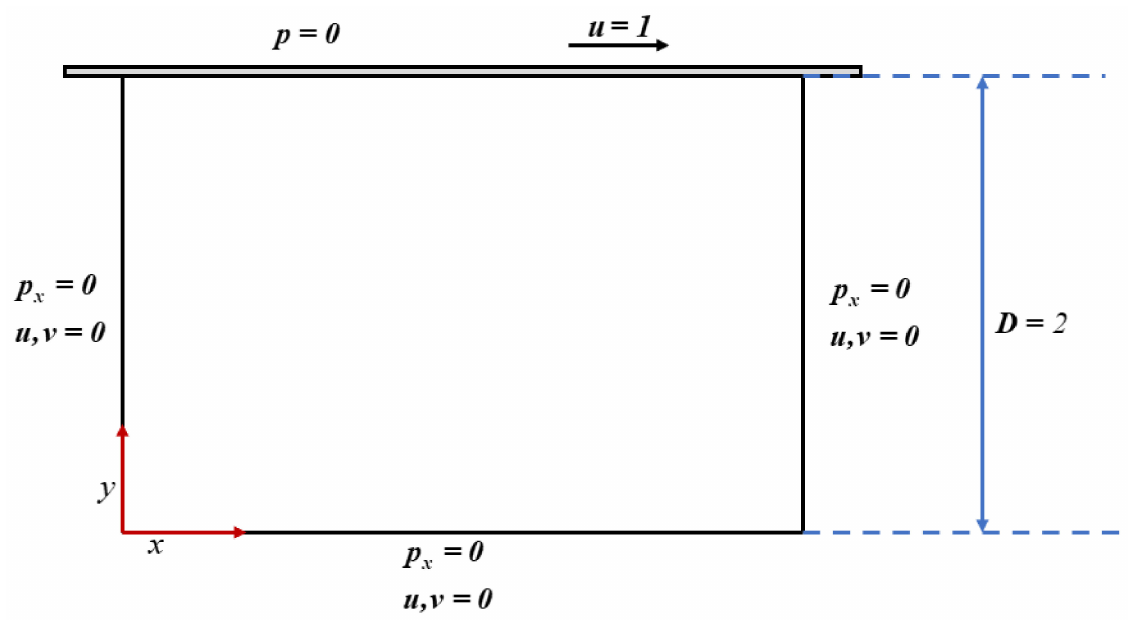
Figure 7. The scenario of the cavity flow with the boundary conditions. Uniform sampling method is utilized to obtain the training data and different samples are chosen to train the model. Before t = 1, the training samples are obtained per 0.1 as a frame and the test samples are selected at t = 1. The process of the calculation can be demonstrated in Figure 8. The time and space coordinates are viewed as input while pressure and velocity are seemed as output. To further investigate the Res-PINN’s accuracy, the parameters like Re are viewed as unknown parameter ( λ 1 , λ 2 ) in loss function. The true values of parameters are 1 and 20. The 8 hidden layers with 20 neurons each layer are selected to construct the FC-NN structure and 400 samples per frame are obtained to calculate the N-S equations. The predicted values can be viewed in Figure 9. Left two panels are exact flow field while right two panels are predicted flow field. It is obvious that the Res-PINN has a good performance in predicting the velocity and pressure. The mean square error of flow field can be viewed in Table 2. In addition, the predicted parameters of λ 1 and λ 2 are 1 and 19.973 which are almost same with the exact values.